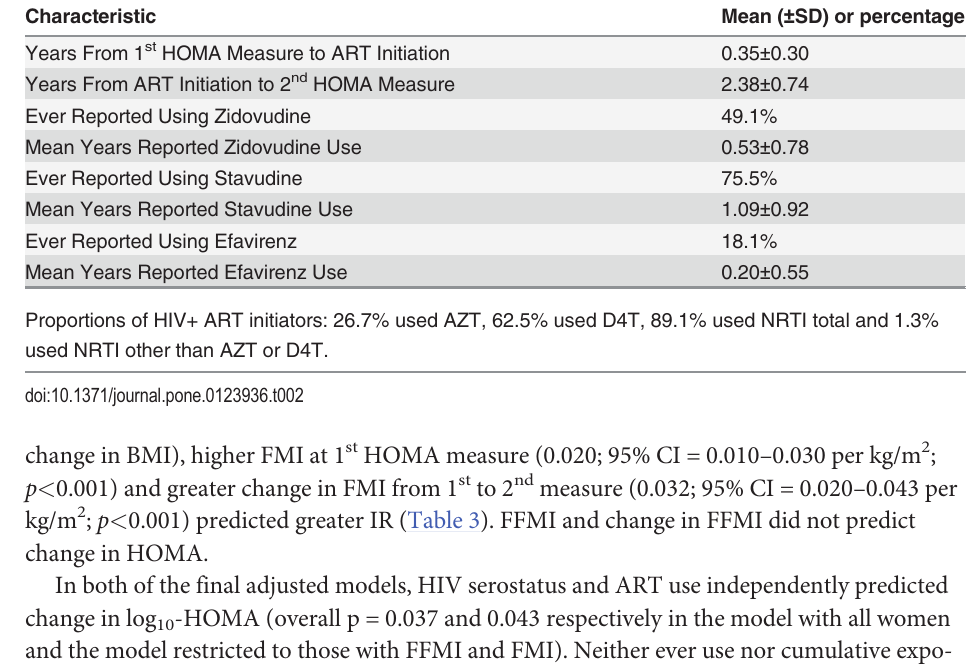
Table 2. Description of ART usage among 371 women who initiated treatment. Characteristic Mean ( ± SD) or percentage Years From 1 st HOMA Measure to ART Initiation